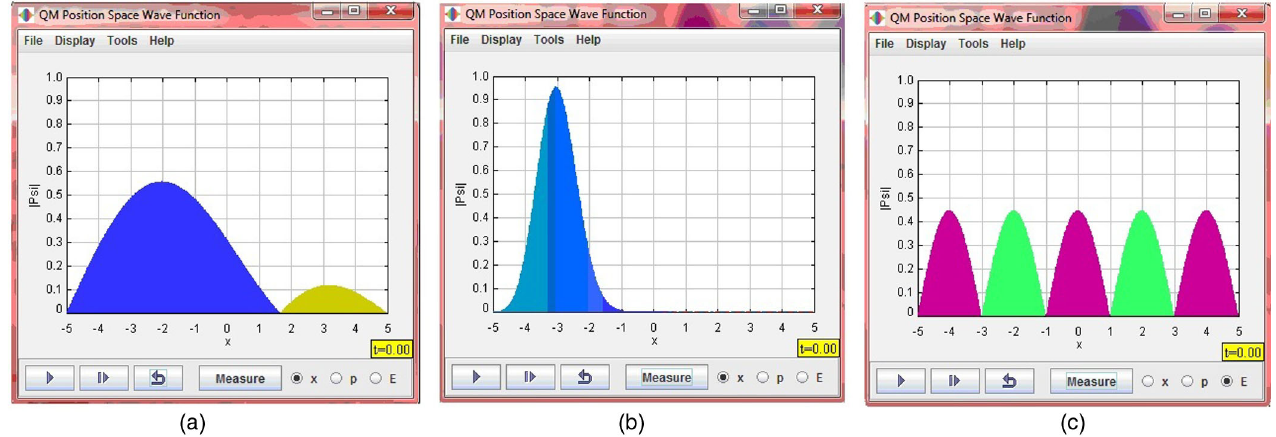
FIG. 8 (color online). Energy measurement after a position measurement of the initial state with only two energy eigenstate components n ¼ 1 and n ¼ 2 as shown in (a). Following the position measurement in (b), the energy measurement yields the energy eigenvalue with n ¼ 5 as shown in (c).